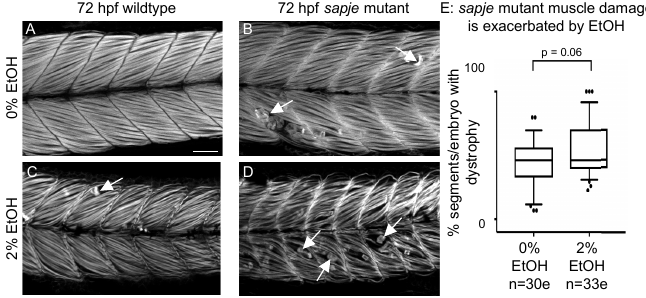
Figure 6. EtOH exacerbates dystrophy in sapje mutants. ( A – D ) Anterior left, dorsal top, side-mounted, 72 hpf embryos stained with phalloidin (white) to visualize actin. ( A ) Wildtype control embryo. Muscle fibers are attached to the MTJ. ( B ) sapje mutant control embryo. A few muscle fibers detach from the MTJ (white arrows). ( C ) Wildtype embryo treated continuously with 2% EtOH from 30 to 72 hpf. A few muscle fibers detach from the MTJ (white arrow). ( D ) sapje mutant embryo treated continuously with 2% EtOH from 30 to 72 hpf. Note the increased number of muscle fibers detached from the MTJ (white arrows). ( E ) Quantification of fiber detachment frequency in sapje mutant embryos without and with EtOH exposure. sapje mutant embryos that were treated continuously with 2% EtOH showed an average increase in fiber detachments per embryo ( p = 0.06). “e” = embryo. Whiskers are 10th–90th percentiles.